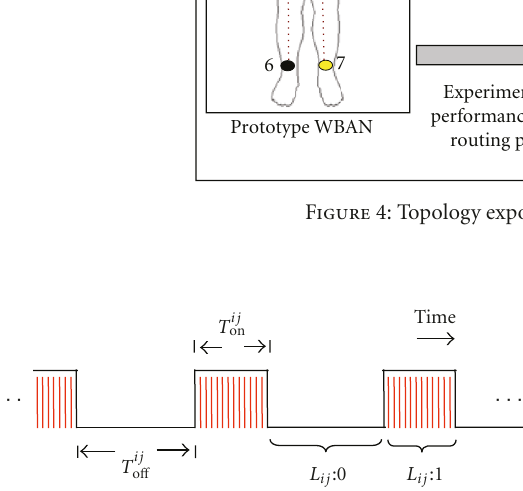
Figure 5: Example connectivity of an on-body